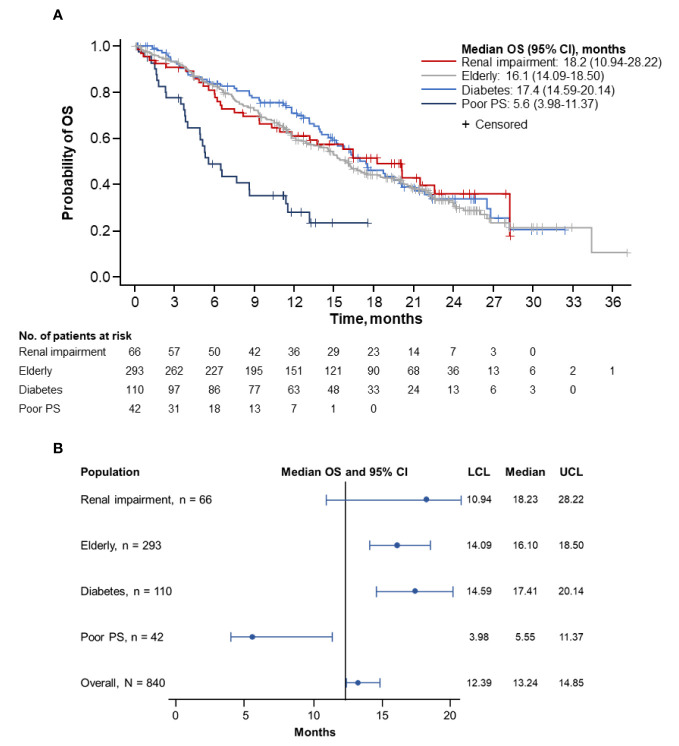
Kaplan-Meier curve (A) and forest plot (B) of OS by population. OS, overall survival; PS, performance status; LCL, lower confidence limit; UCL, upper confidence limit.